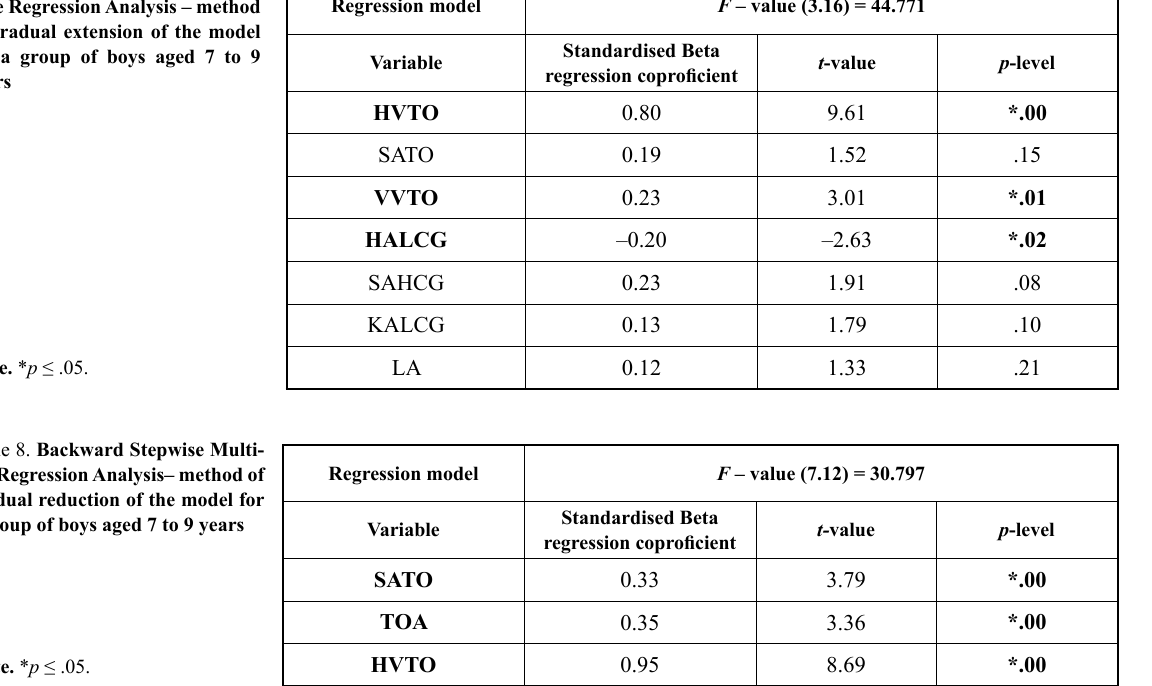
Table 7. Forward Stepwise Mul - tiple Regression Analysis – method of gradual extension of the model for a group of boys aged 7 to 9 years